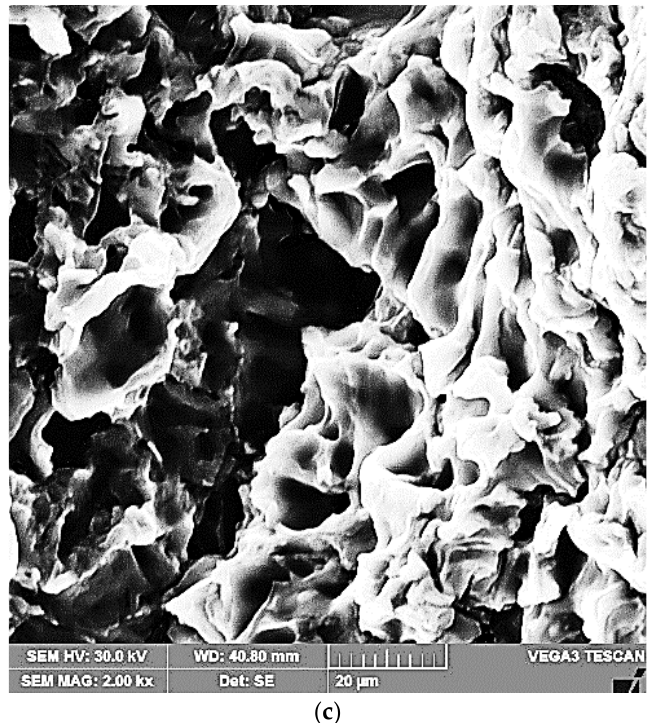
Figure 12. SEM image of the remelted surface, with Is = 100 A, and tested after 165 min for cavitation: ( a ) ×20; ( b ) ×500; ( c ) ×2000.